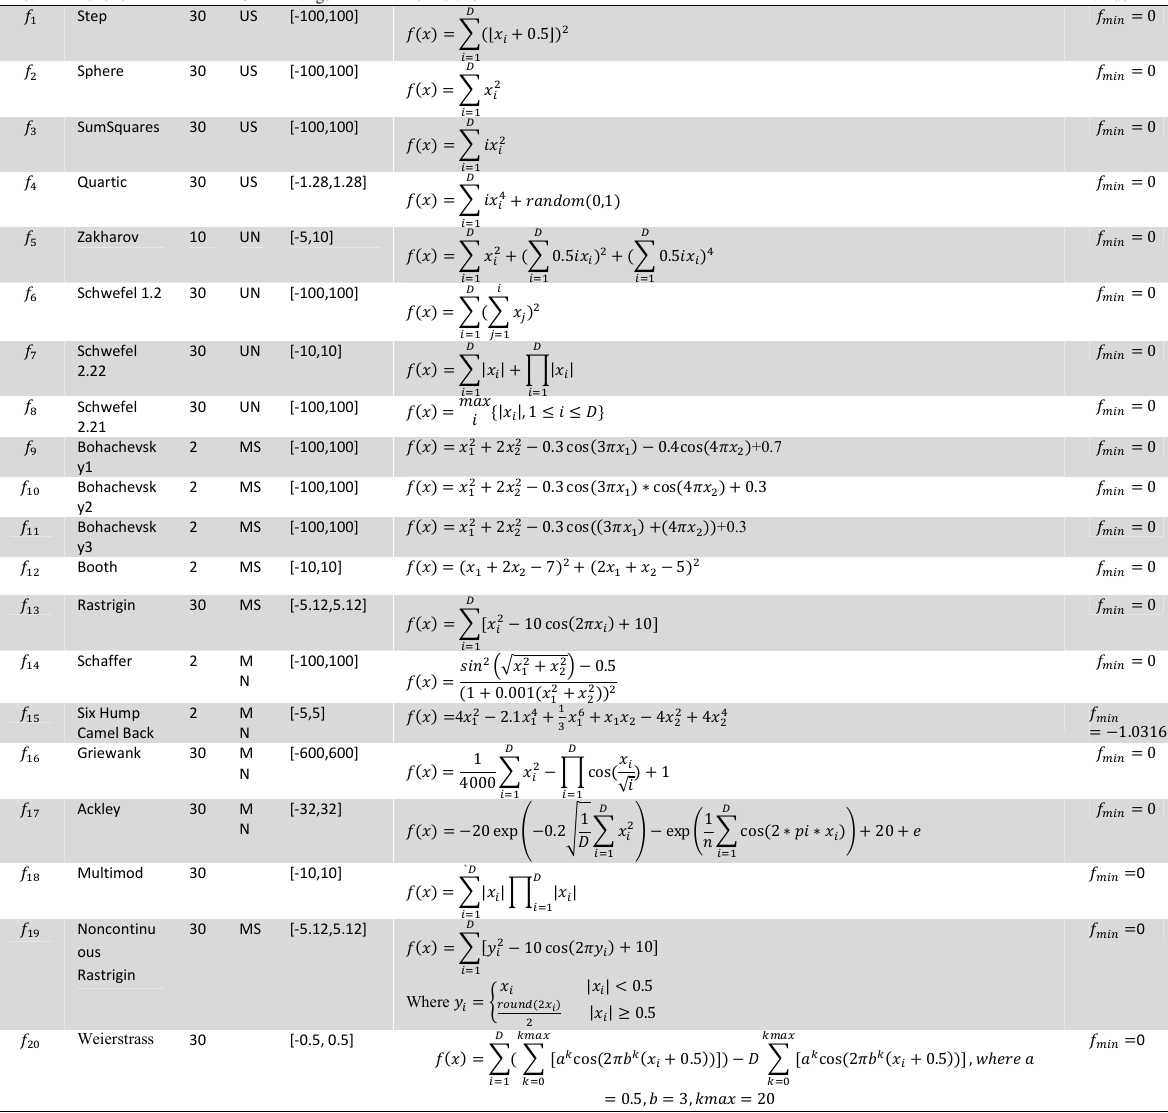
Benchmark functions used in experiments 1. D: Dimension, C: Characteristic, U: Unimodal, M: Multimodal, S: Separable, N: Non-Separable